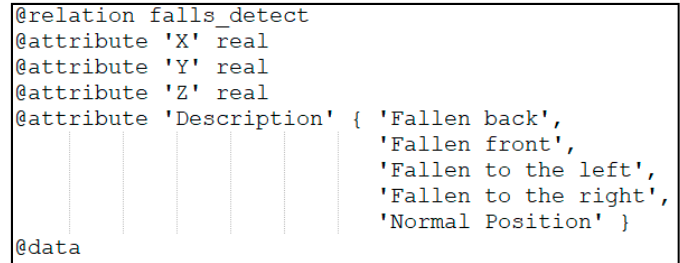
Figure 8. Data fields definition for test on the WEKA model .